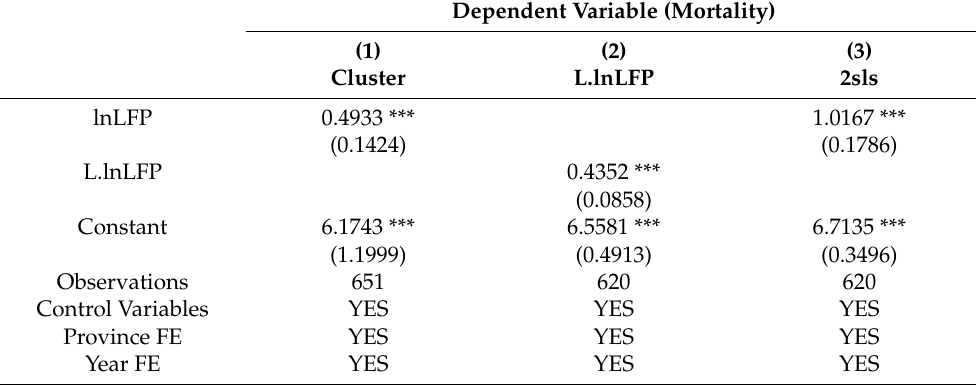
Table 3. Robustness check